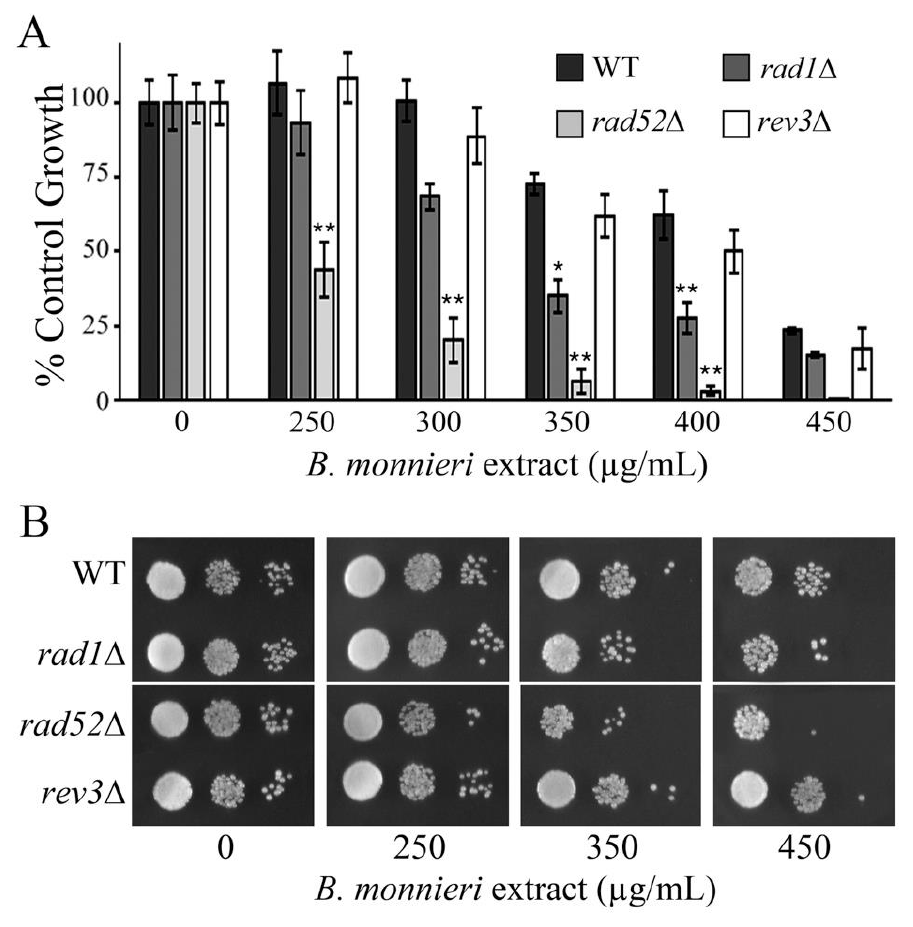
Figure 9. Yeast deleted for RAD52 are sensitized to B. monnieri extracts. ( A ) Yeast cultures were grown as described in Figure 3 with the indicated concentration of B. monnieri extracts. Strains utilized include WT (BY4742), rad1 ∆ (12806), rad52 (10540), and rev3 ∆ (12085). Values are mean ± SD ( n = 3). Statistical analysis employed Student’s t -test with ** p < 0.01 and * p < 0.05. ( B ) Serial dilutions of liquid cultures from were spotted onto solid synthetic medium with 2% glucose as described in Figure